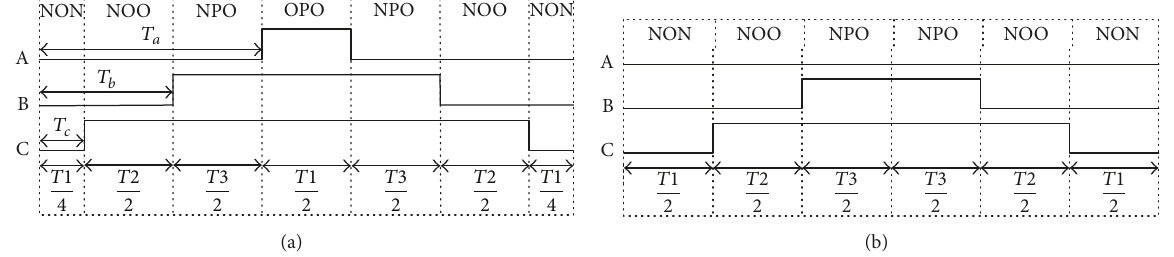
Figure 8: The sequence of voltage vectors and its action times in region III-2. (a) Conventional switching sequence. (b) After the switching sequence is rearranged.